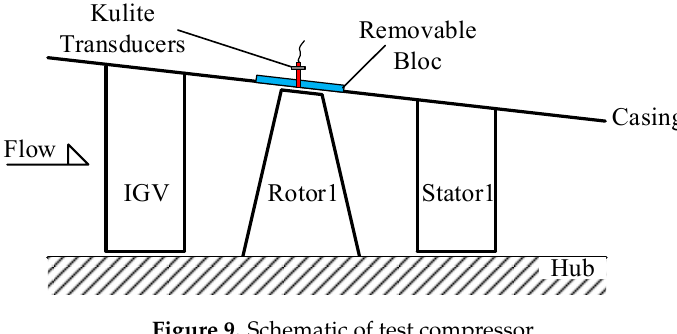
Figure 9. Schematic of test compressor. Sensors 2019 , 19 , x FOR PEER REVIEW